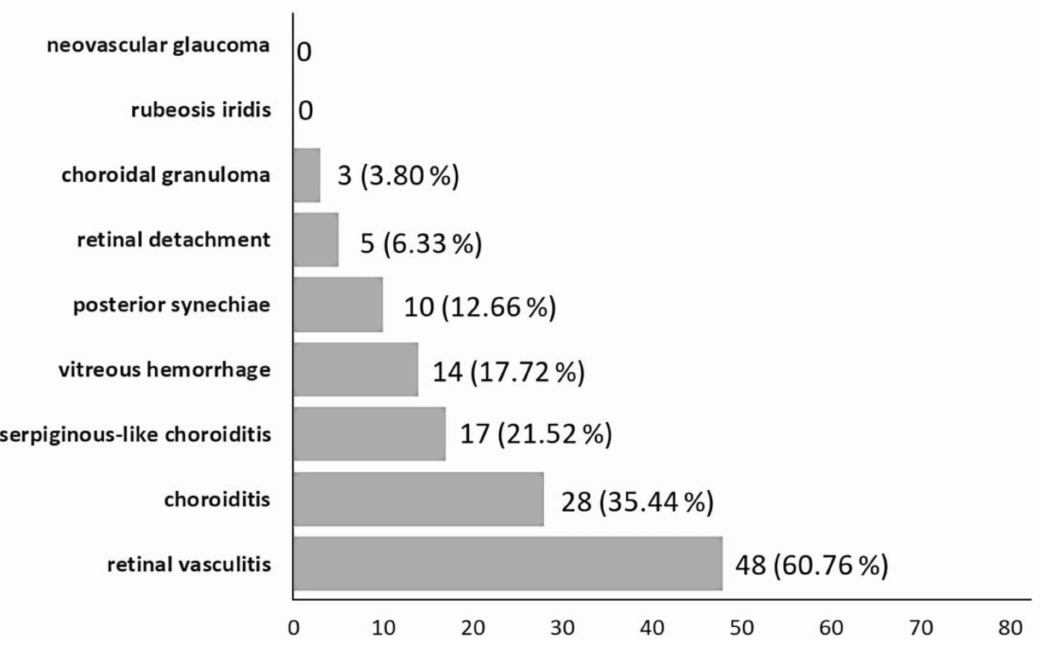
Figure 1. Breakdown of clinical manifestations of tubercular uveitis.